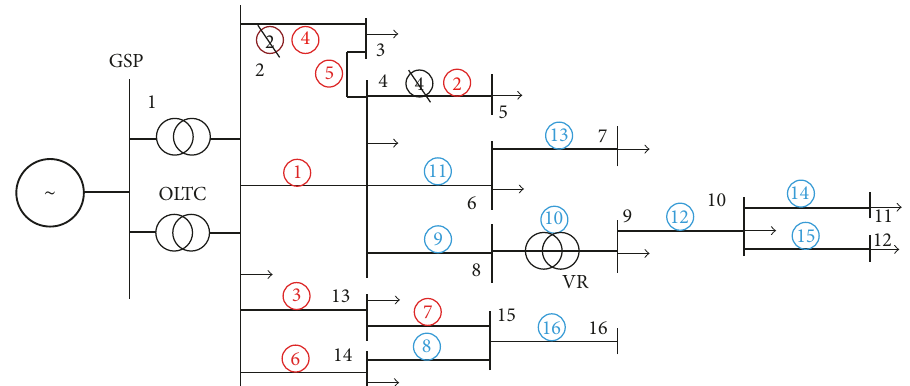
Figure 3: Ranking of branch in UKGDS 86 with DGs.